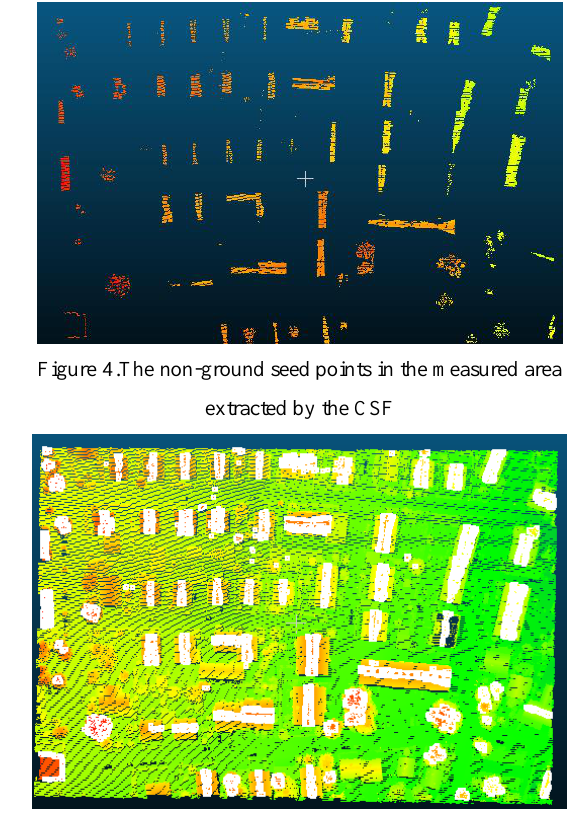
Figure 8.The non-ground point in the measured area filtered by the CSF(superimposed on source